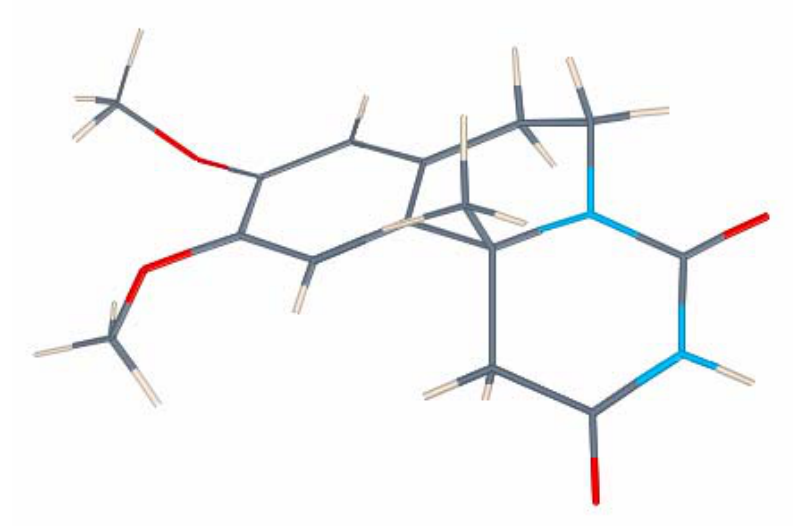
Figure 2. 3D Model of 5b , showing the different orientations of the hydrogens at C-6. Calculations were performed using the PC GAMESS version [18] of the GAMESS (US) QC package